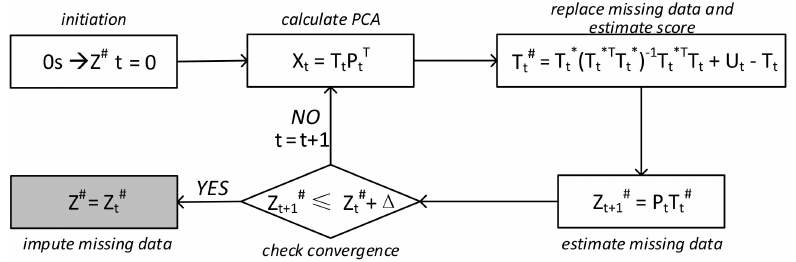
Figure 3. The PCA–TSR data imputation